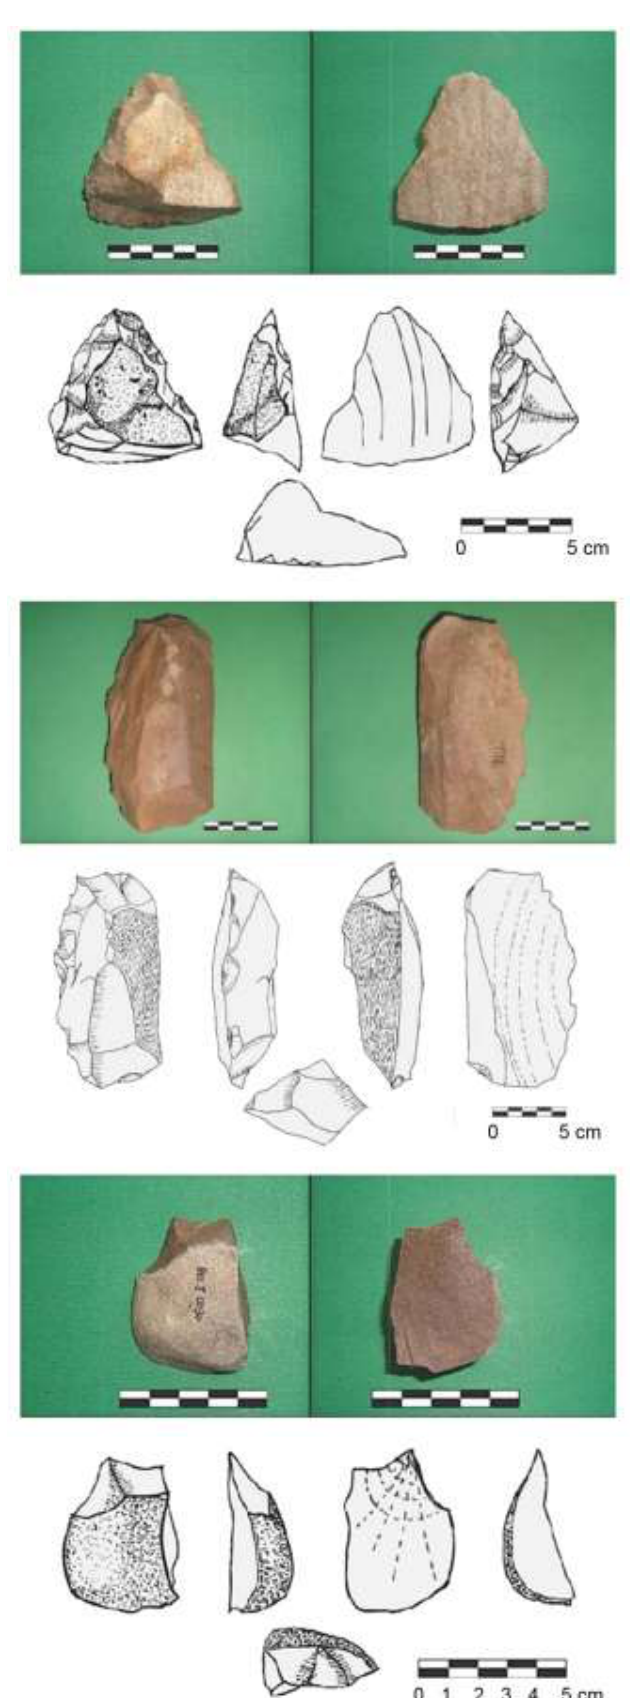
Figure 10. Silicified sandstone artifacts from site BE II. Source: adapted from Santos Journal of Lithic Studies (2019) vol. 6, nr. 1, p. xx-xx DOI: https://doi.org/10.2218/jls.2783